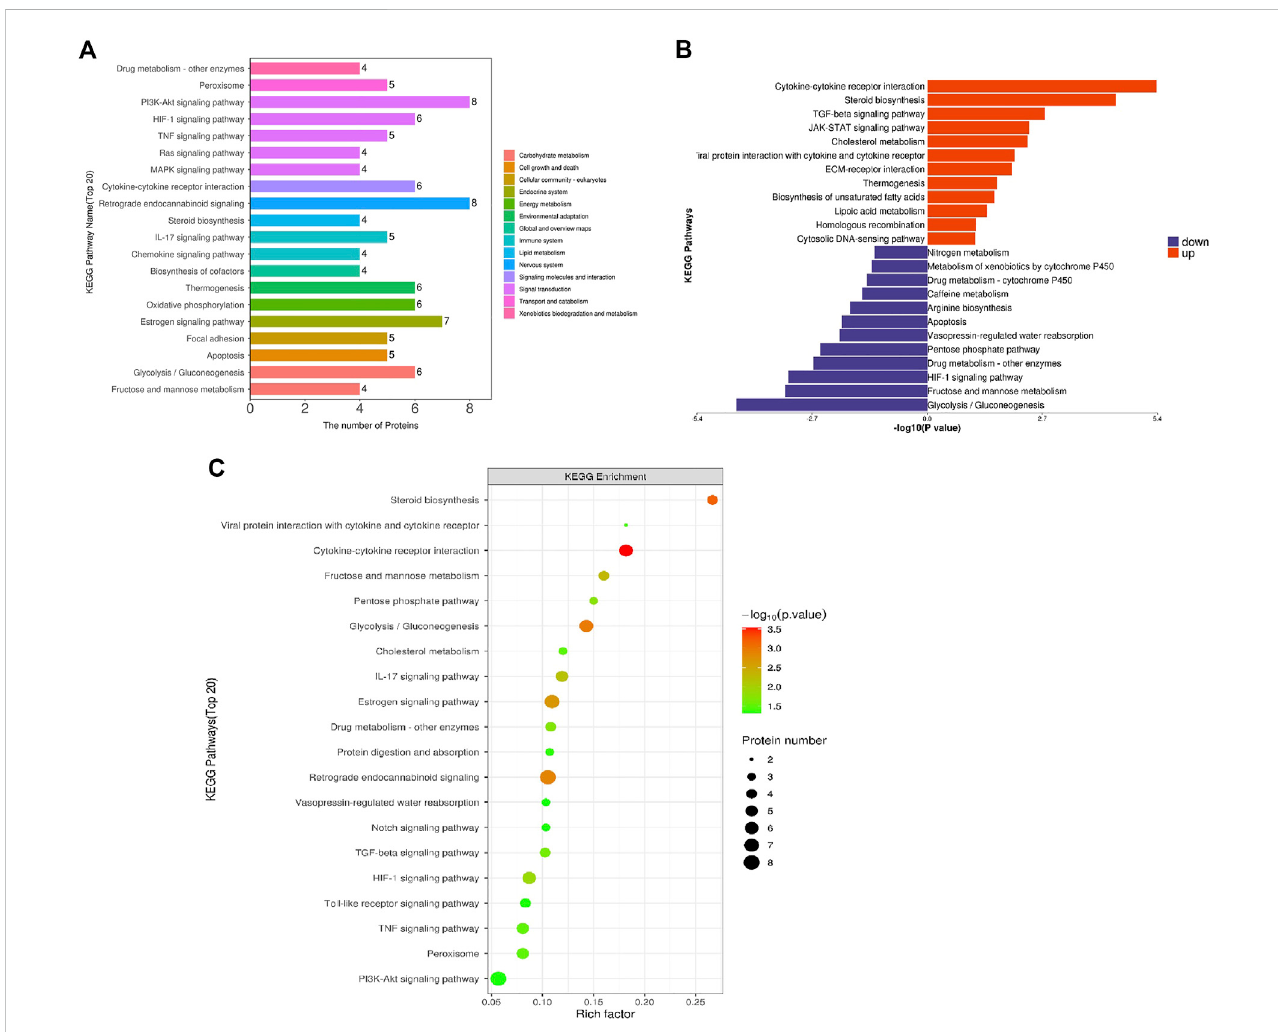
FIGURE 3 KEGG pathway enrichment analysis of differentially expressed proteins in loperamide-treated HT22 cells. (A) KEGG pathway annotation statistics for differentially expressed proteins. (B) KEGG pathway differential expression analysis map. (C) KEGG pathway enrichment bubble map.